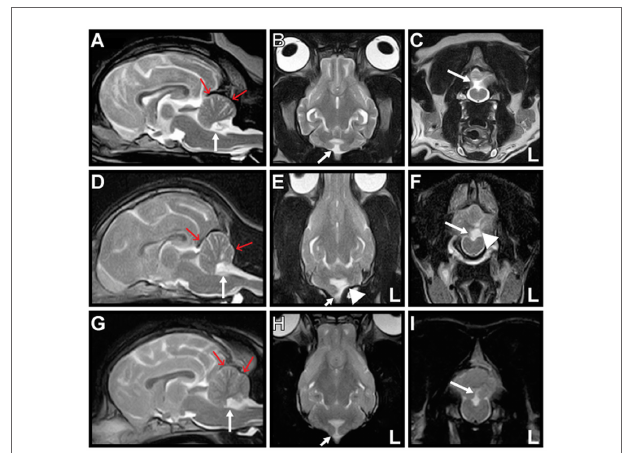
FIGURe 1 | Magnetic resonance t2-weighted images of Cases 1–3 . Mid-sagittal (a,D,G) , dorsal (B,e,H) , and transverse (C,F,I) images are shown. The nodulus and ventral uvula of the cerebellum (arrow) are absent in all cases. The caudal fossa (red arrows) is reduced in size, indicating hypoplasia in all cases. There is also partial absence of the left cerebellar hemisphere (arrowhead) in Case 2 (e,F)